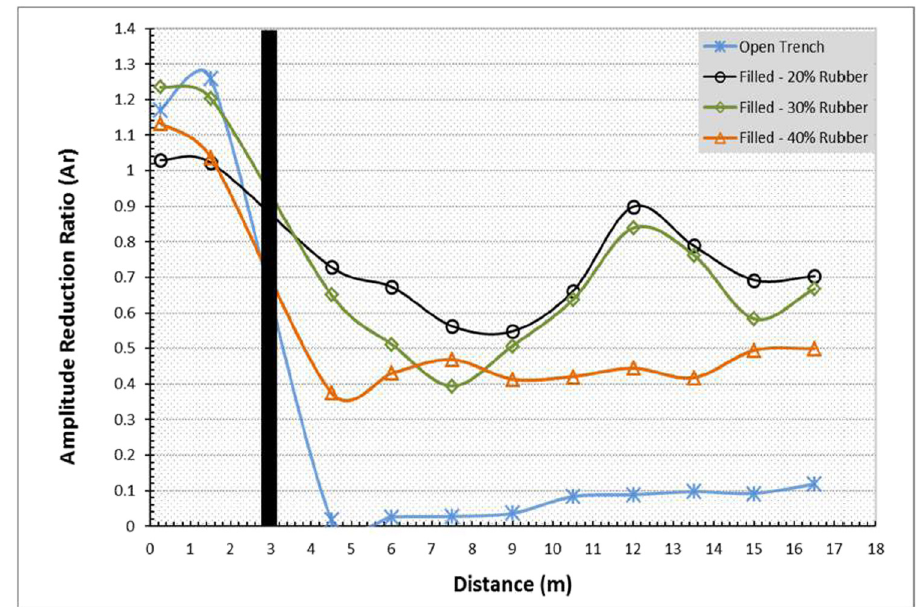
Figure 16: Attenuation of vibration due to active trench barriers ( f 55 Hz = ) .